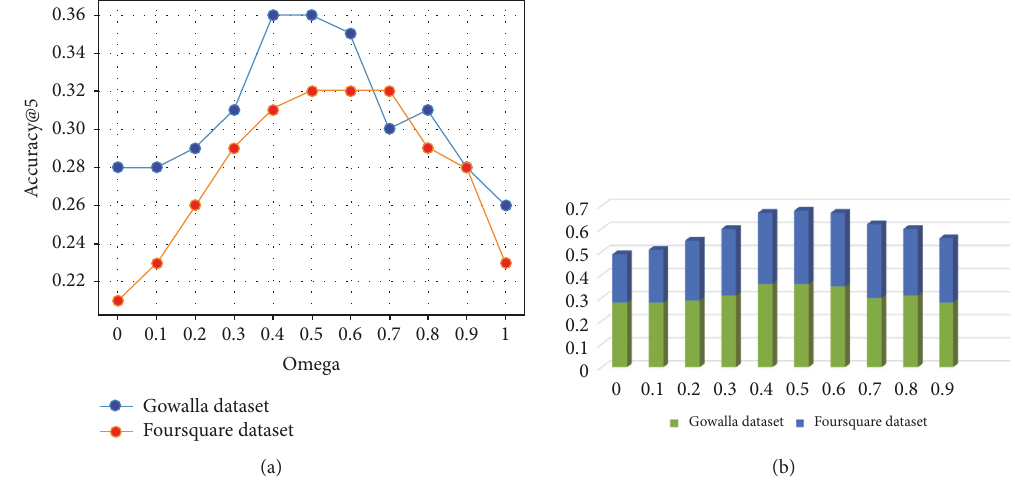
Figure 2: Choice of different combining factor between social interests and travel preference objectives.